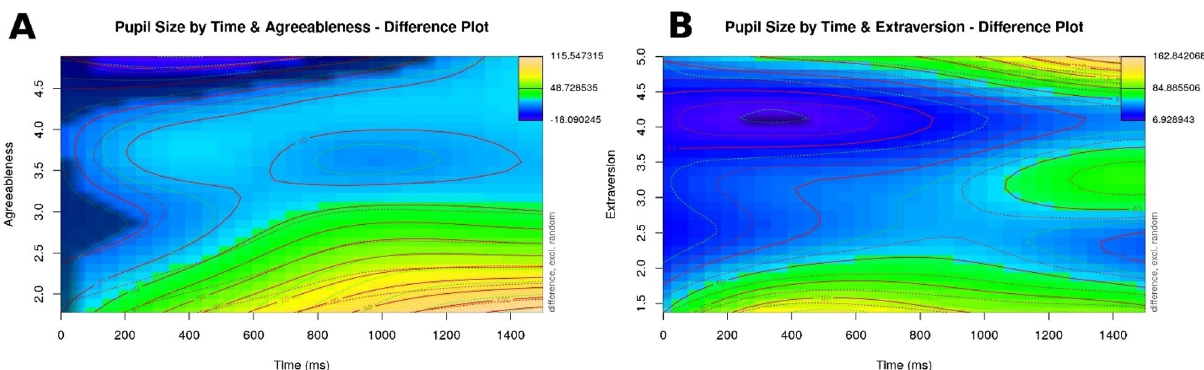
Figure 4. Visualization of the effects of item rating and the listener’s Agreeableness (Panel A) and Extraversion (Panel B) on pupil size over time in response to semantic anomalies. Plots were generated using the itsadug (Version 2.3 63 ) package in R.